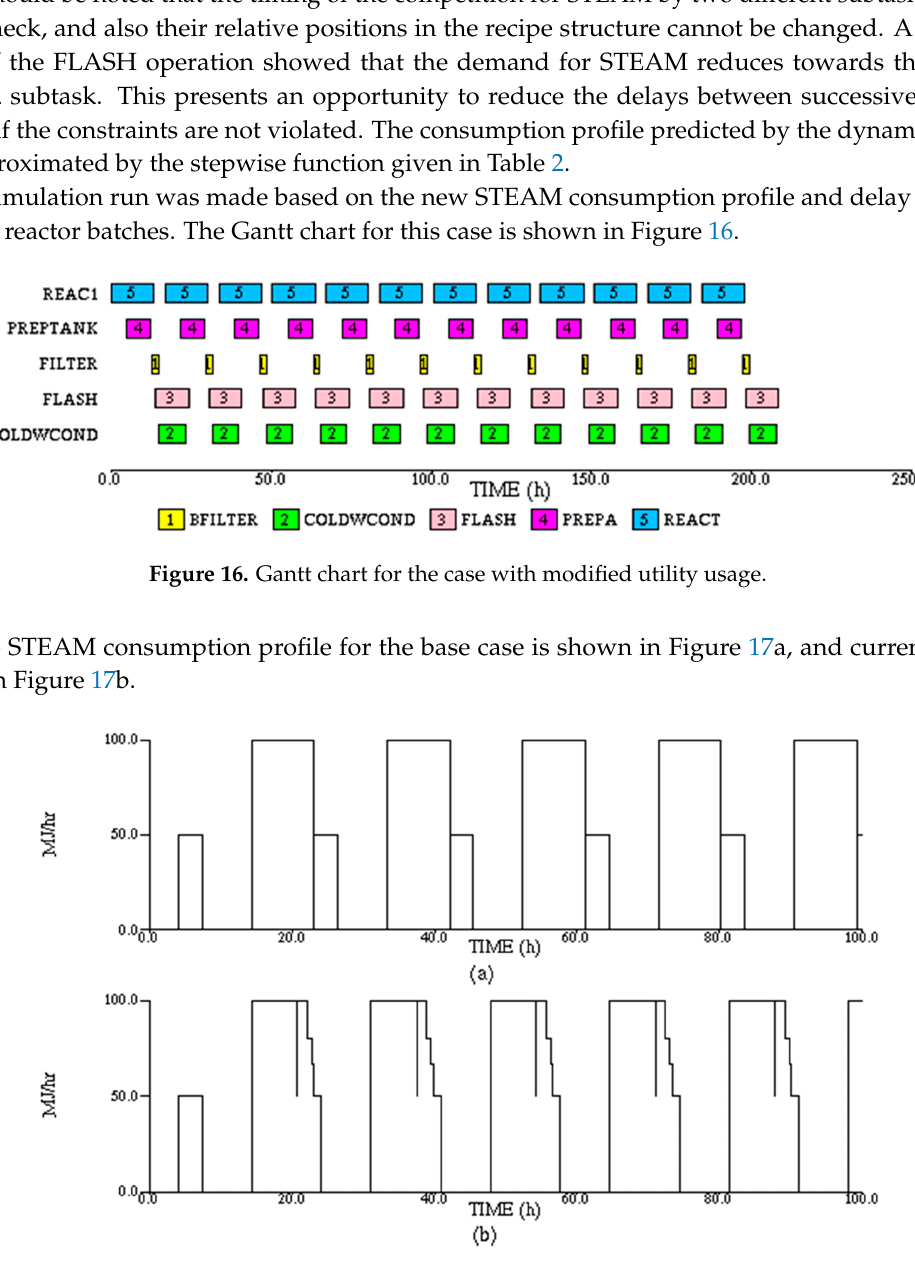
Figure 17. Steam consumption profiles for two cases: ( a ) the base case, ( b ) the current case.